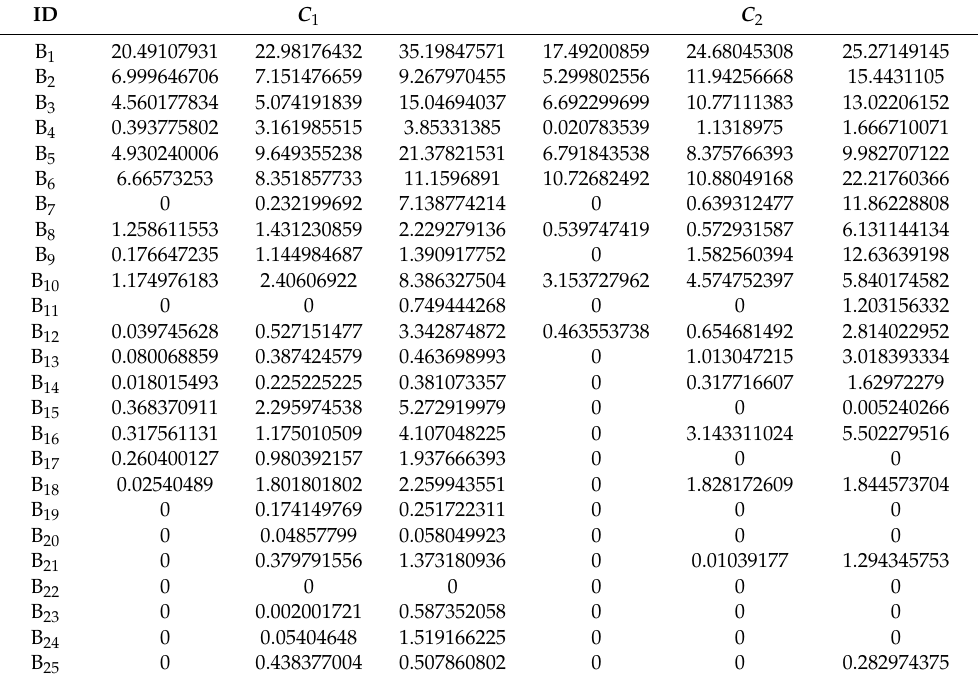
Table A2. Fuzzy evaluations of bacteria concentration referred to the February 2012